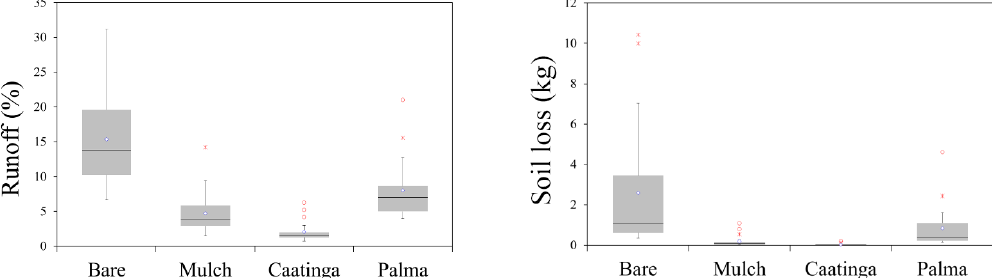
Figure 8. Box plots for runoff and soil loss, for native vegetation (Caatinga), Cactus barriers (Palma), mulching and bare soil, at the experi- mental plots, at site 1, for the 0–0.20m